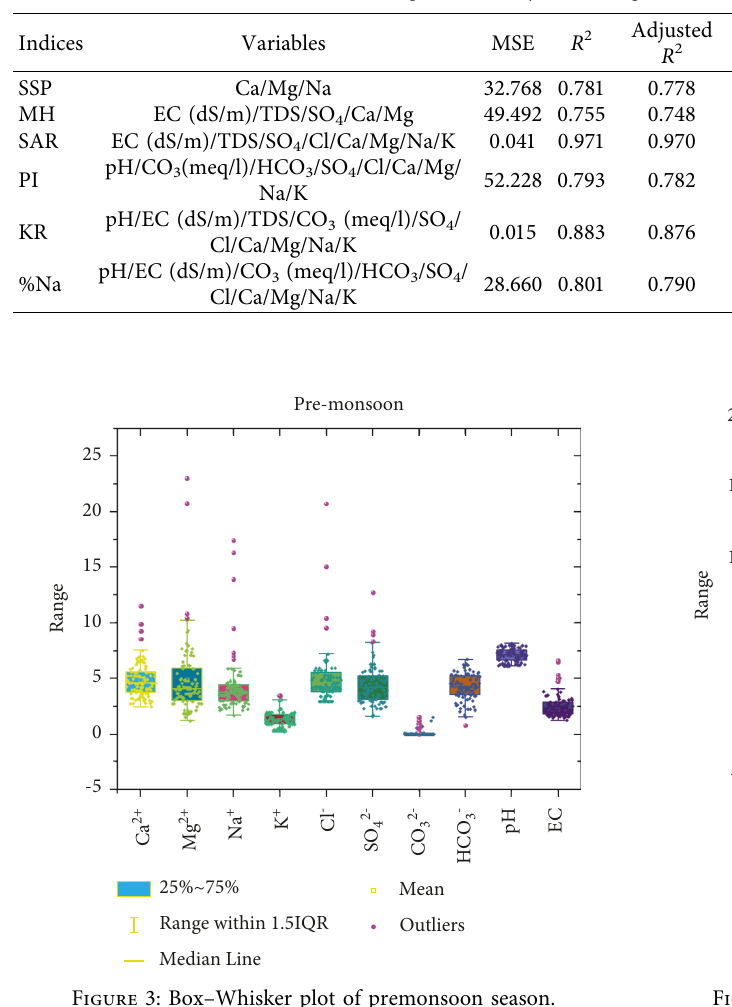
Table 5: Best subset regression analysis for irrigation water quality indices input combinations.